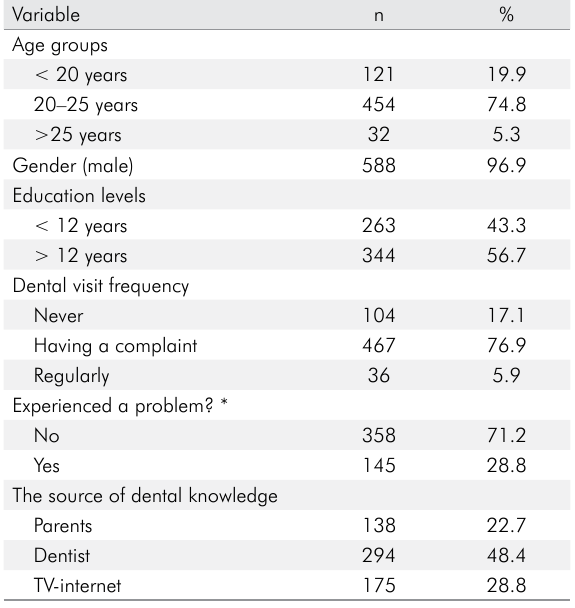
Table 1. Descriptive features of the participants (n =